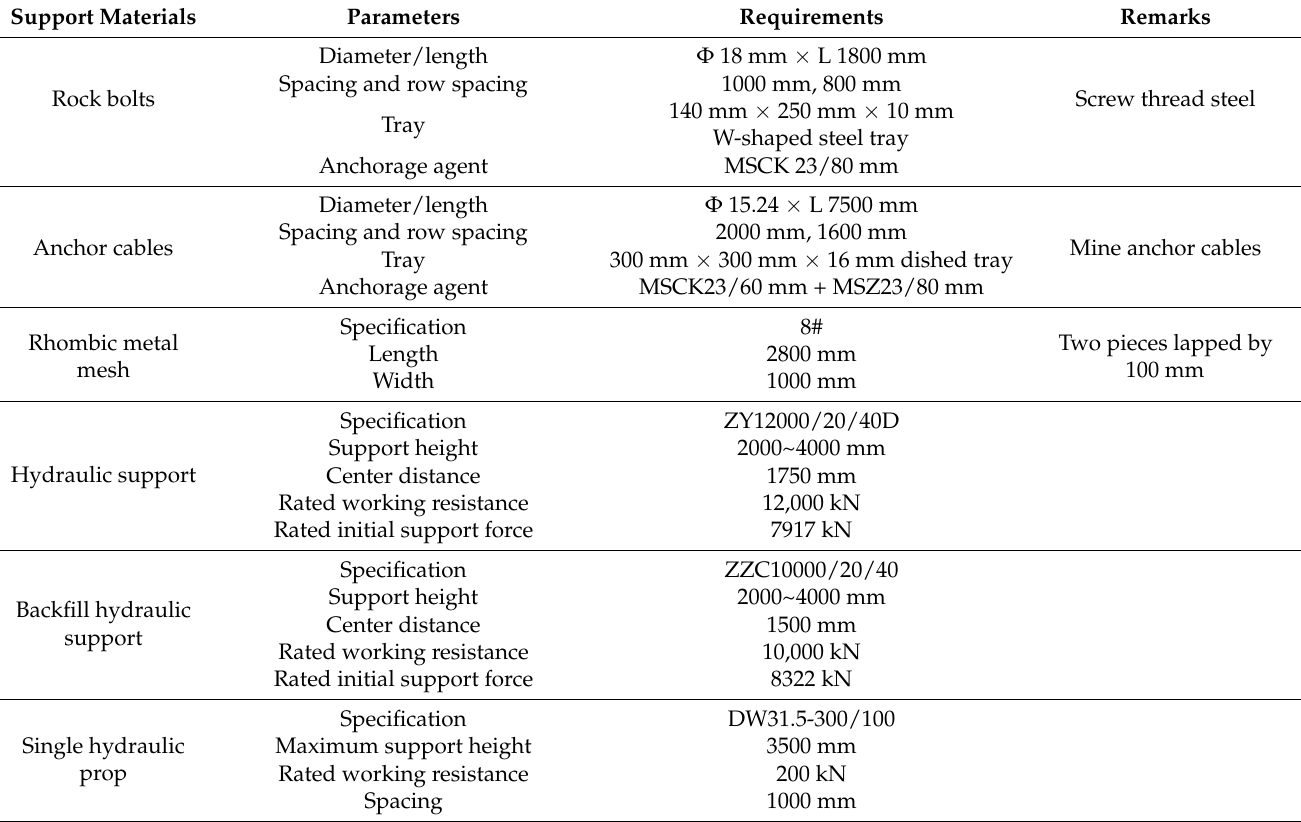
Figure 5. The relationship and relative location of the yield coal pillar, working face, interchange bridge and the structure backfill area. Table 2. Initial roof support parameters in the backfill